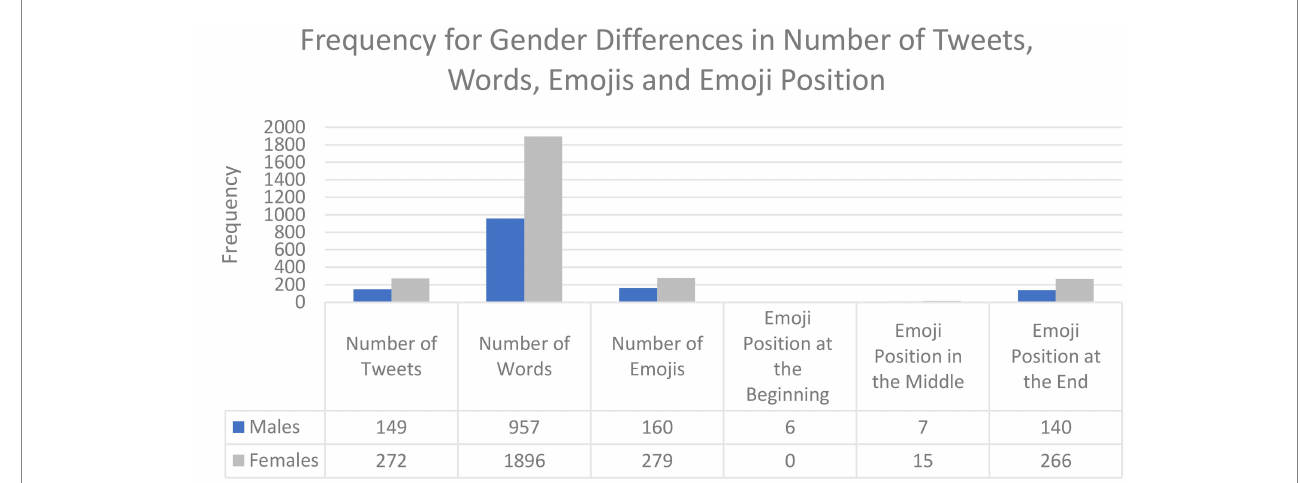
FIGURE 11 Gender differences in the number of tweets, frequency of words and emojis, and emoji position in Arabic